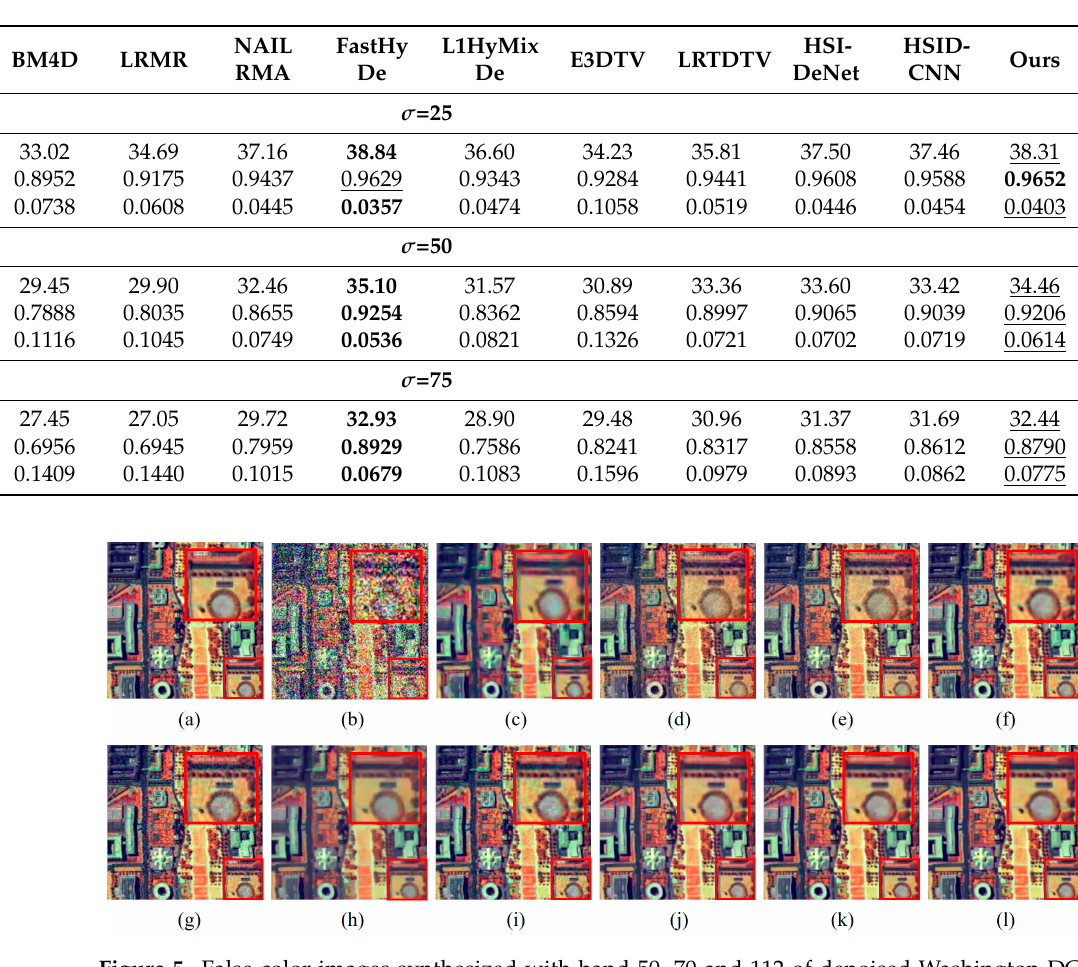
Table 1. Quantitative assessment of different algorithms applied to Washington DC Mall data with Gaussian i.i.d. noise.